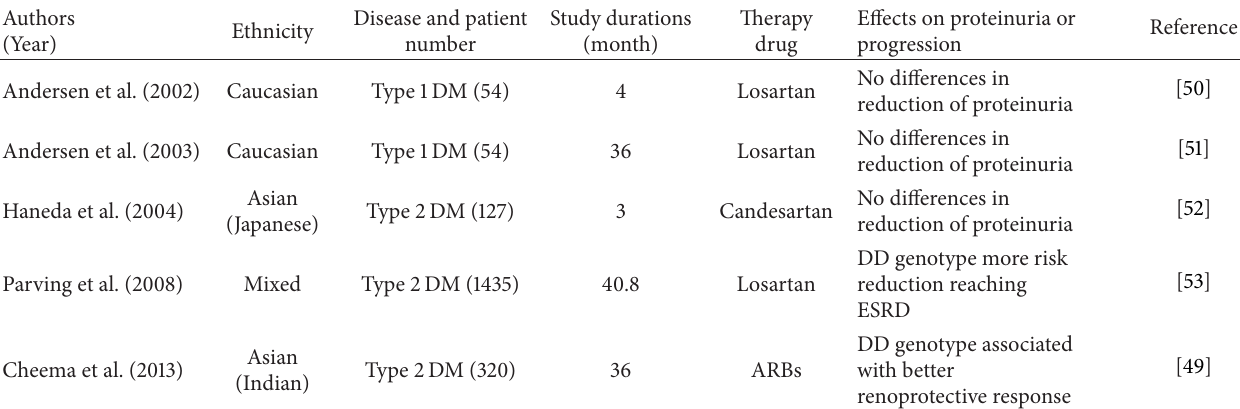
Table 2: Studies examining the association of the ACE I/D polymorphism and response to antiproteinuric (renoprotective) effect of ARB